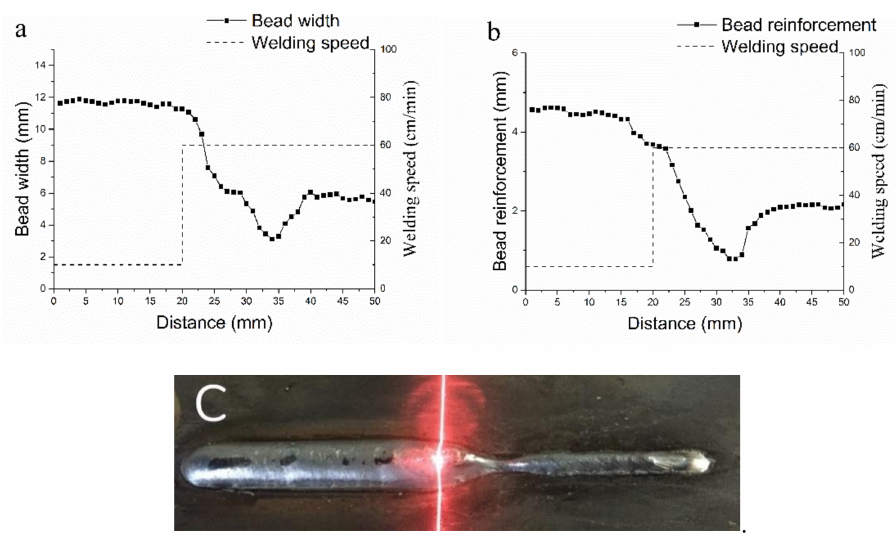
Figure 4. Results of transient response test (welding speed steps from 60 cm/min to 10 cm/min.). ( a ): bead width value; ( b ): bead reinforcement value; and, ( c ): actual